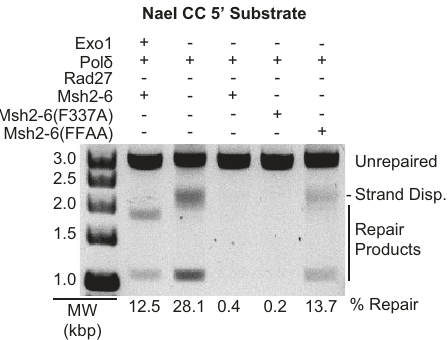
Fig. 5 Effect of substituting wild-type Msh2-Msh6 for two different mutant Msh2-Msh6 complexes when omitting Rad27. Representative assay of 5 ′ nick-directed repair of the CC substrate in which different proteins were omitted or substituted as indicated. All reactions also contain PCNA, RFC- Δ 1N, and RPA. The amounts of all proteins used in the assays are as listed in the “ Methods ” section. MW, molecular weight markers. The percent repair corresponds to the fraction of all DNA in each individual lane susceptible to PstI cleavage, including those labeled “ strand displacement ” and “ repair products ” . Three independent experiments were